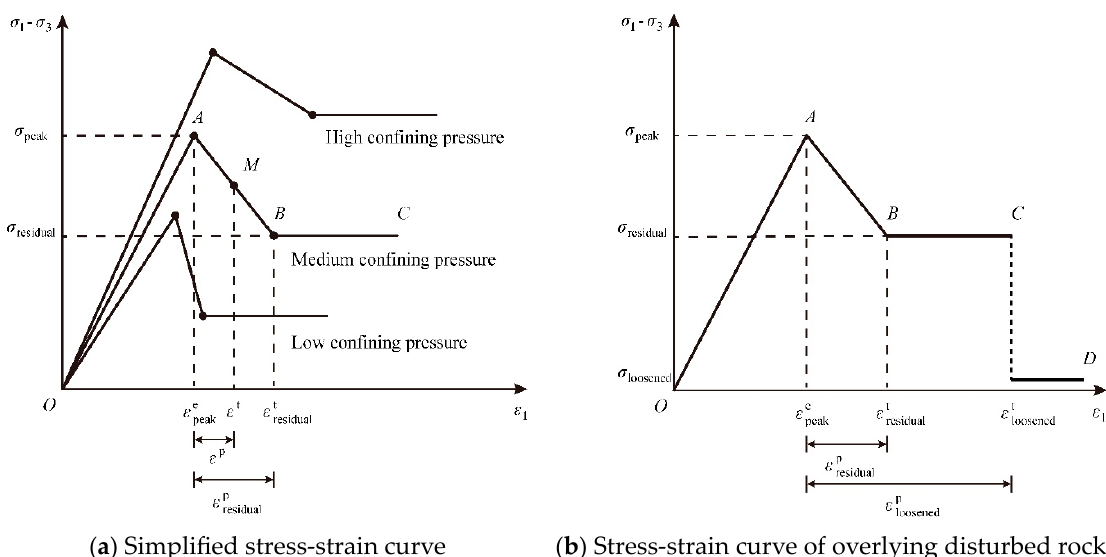
; and Stage IV (Section CD) is the caved material defor- mation stage, i.e., 𝜀 (cid:3043) ≥ 𝜀 (cid:3039)(cid:3042)(cid:3042)(cid:3046)(cid:3032)(cid:3041)(cid:3032)(cid:3031)(cid:3043) . More details are shown in Figure 4.